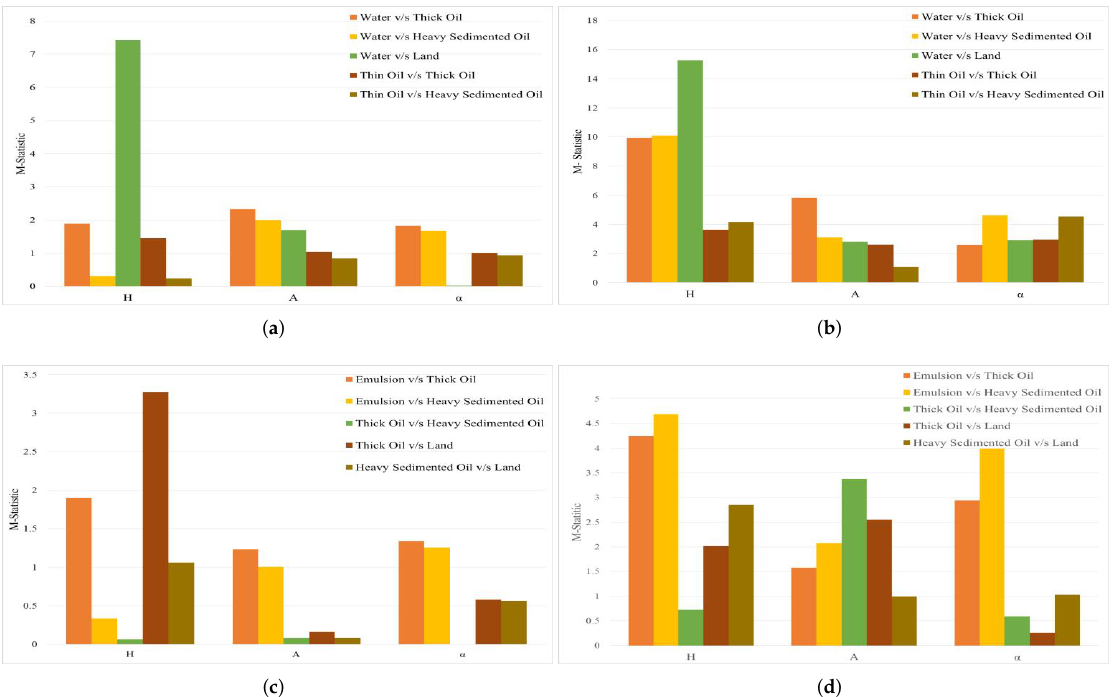
Figure 13. M-Statistic result analysis with respect to different types of polarimetric feature. For Conventional T3 ( a ) Different types of oil slick versus seawater& ( c ) Comparison of Different type Weathered Oil slick and look-alikes. For Proposed Log Transformed T3 ( b ) Different types of oil slick versus seawaterand ( d ) Comparison of Different type Weathered Oil slick and